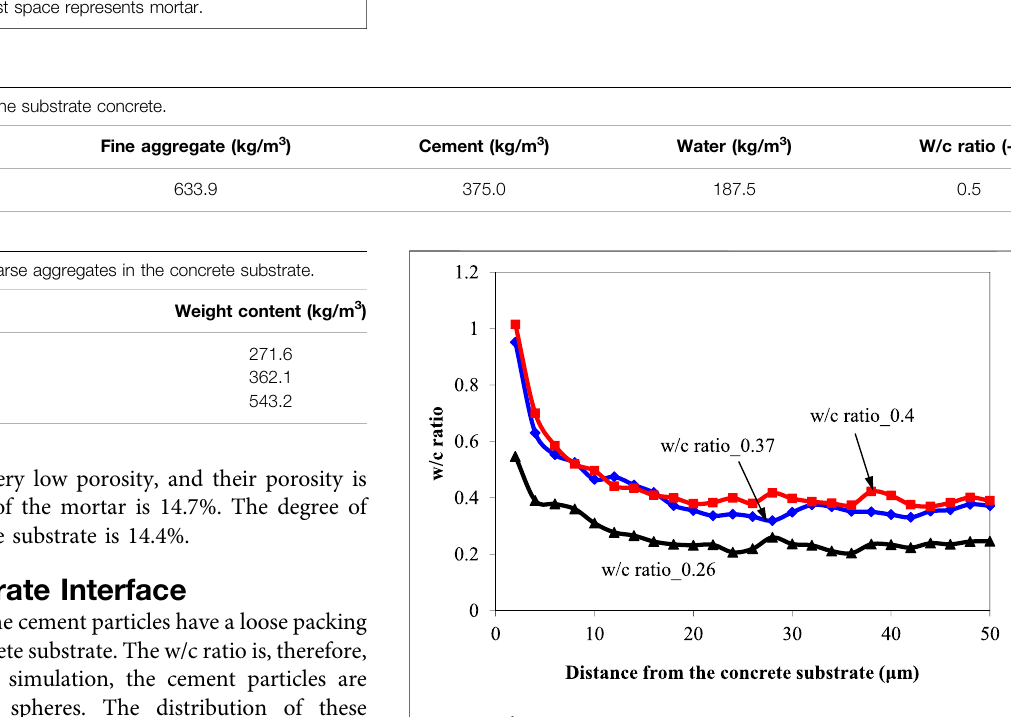
FIGURE 6 | Local w/c ratio versus the distance from the concrete substrate in the cement pastes with overall w/c ratios of 0.26, 0.37 and